Question: Which visualization type does this figure use?
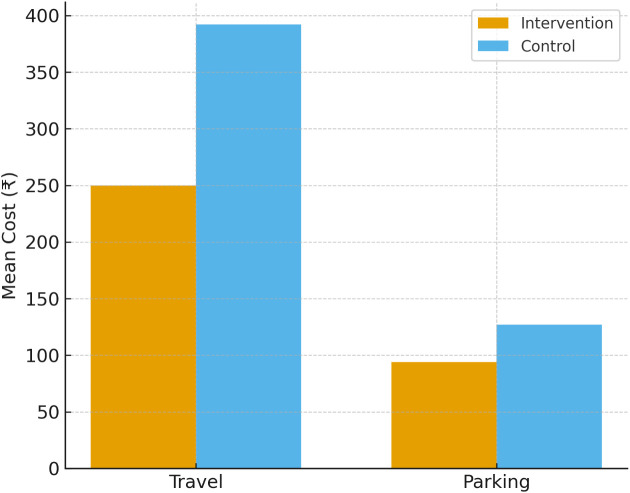
Answer: bar